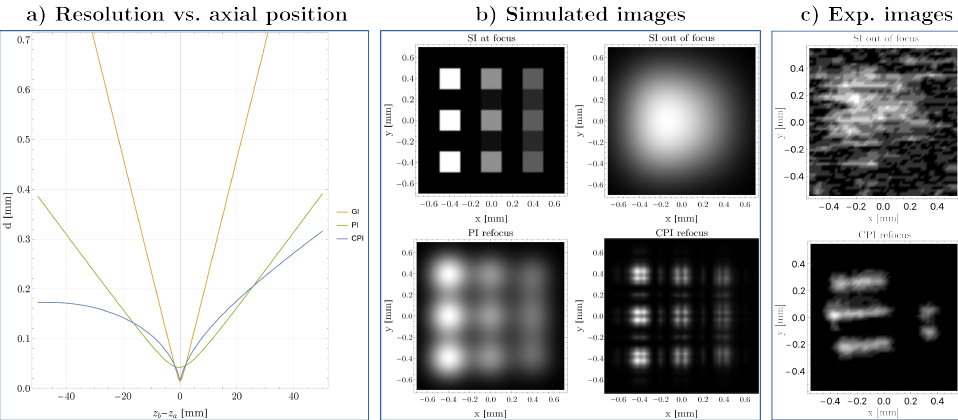
Figure 2. ( a ) shows the resolution limits, as a function of the longitudinal position, of the image of a double-slit mask with center-to-center distance d equal to twice the slit width; here, CPI outperforms both conventional imaging and standard PI with 3 × 3 directional resolution. The evident asymmetry of the CPI curve is due to the existence of two planes in which the object is focused: one at z b = z a and one at z b = 0 (see [16]). Plots in ( b ) show a result of a simulation: the target is moved from the focused plane (top left) to an out-of-focus plane (top right). Starting from this position, we show the results of PI refocusing with 3 × 3 directional resolution (bottom left) and the CPI refocusing (bottom right); ( c ) shows the results of an experiment [16] in which the standard image of a triple slit was completely blurred (top), while the image obtained by CPI (bottom) was made fully visible by exploiting information on light direction. Plots in ( c ) are reproduced with the permission from Ref. [16], copyright American Physical Society,